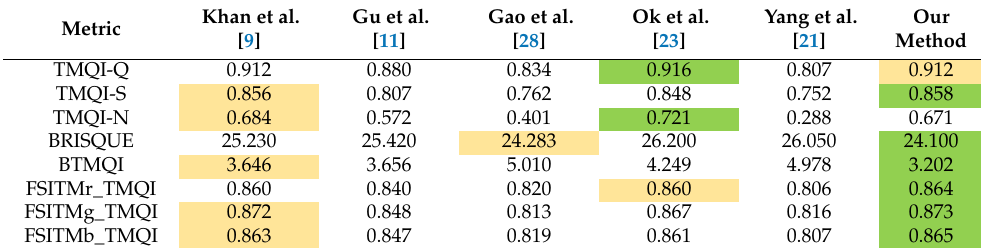
Table 5. Average score of different objective evaluations for the dataset in [29]. Metric